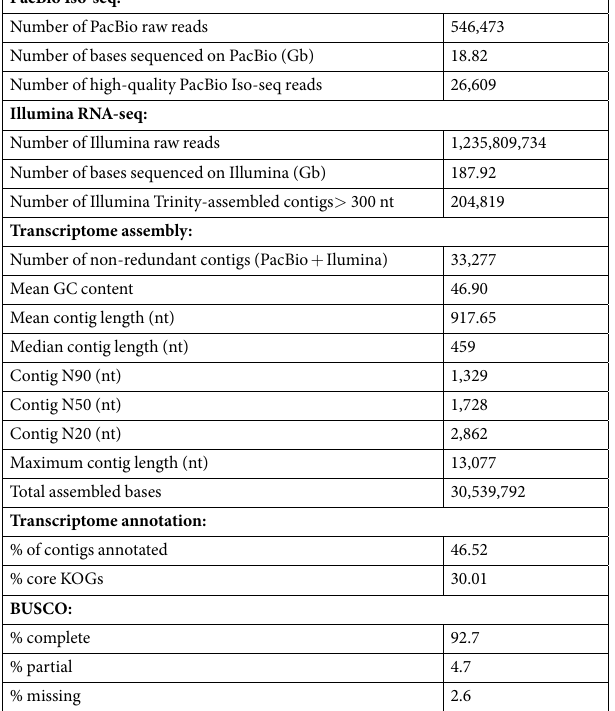
Table 1. Assembly statistics for P . monodon